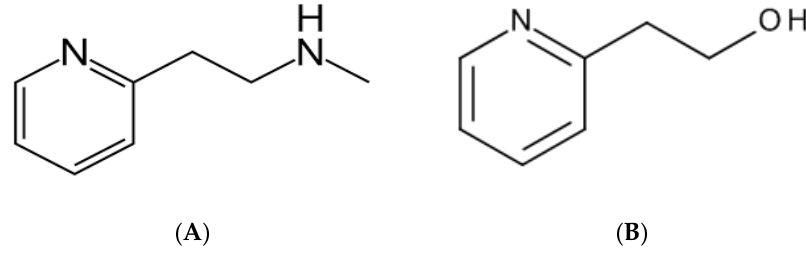
Figure 1. Chemical structure of ( A ) BHS, and ( B ) HEP.